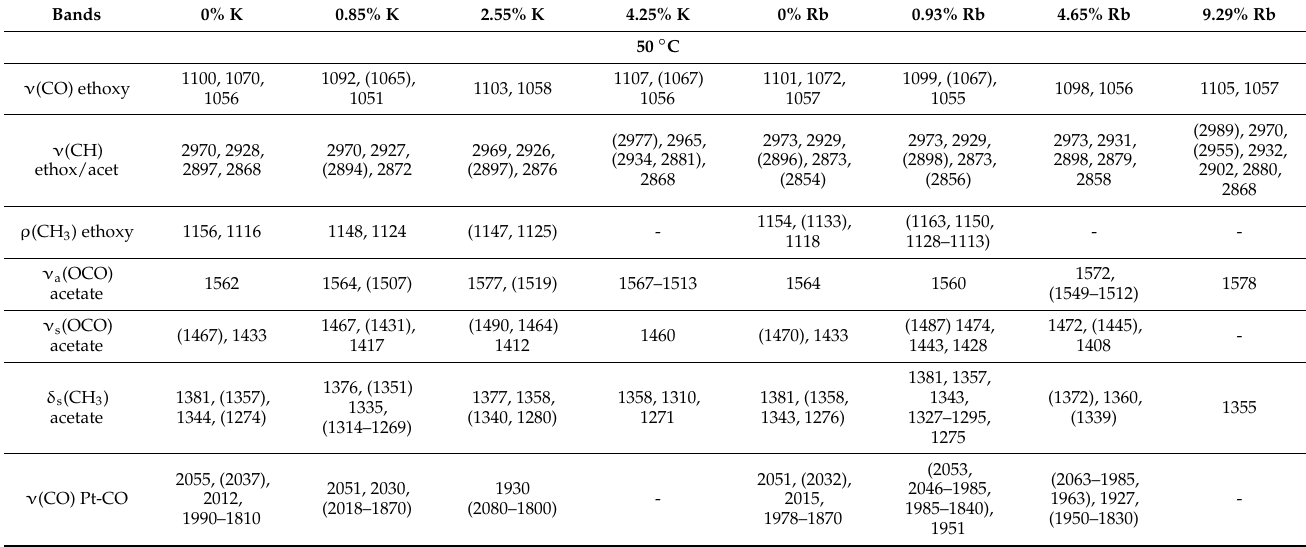
Table 2. Main bands in cm − 1 observed for unpromoted, K-promoted, and Rb-promoted 2% Pt/ZrO 2